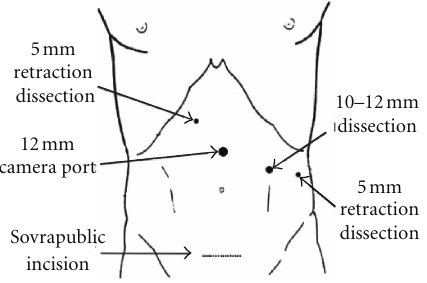
Figure 1: Computed tomography showing a hypodense mass of the spleen with contrast enhancement during arterial phase.